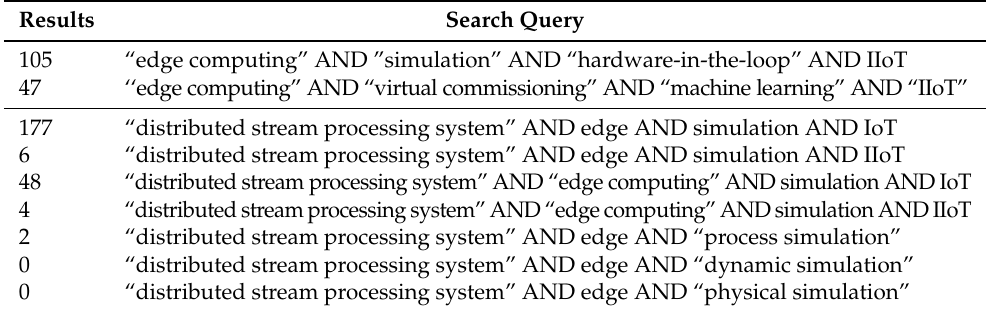
Table 1. Number of results for different search queries using Google Scholar (September